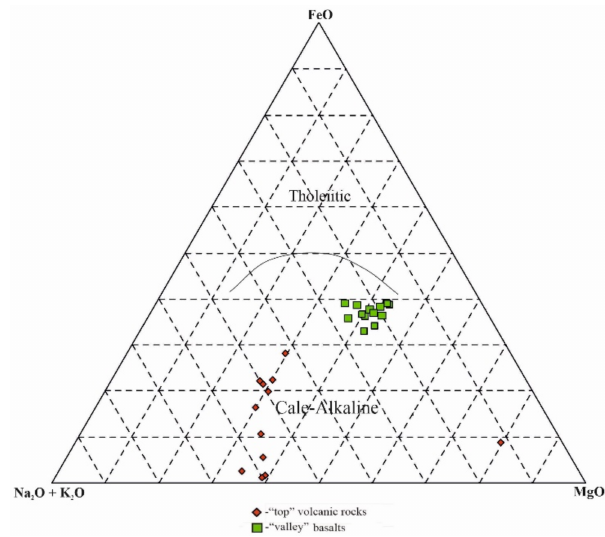
Figure 12. AFM diagram for volcanic rocks, fields according to [22]. The “valley” volcanic rocks contain a higher amount of TiO 2 (from 2.6 to 2.8 wt. %) than the “top” volcanic rocks (from 2.3 to 2.5 wt. %). The same trend is observed for the values of CaO: for the “valley” volcanic rocks, the values range from 8.5 to 9.75 wt. %;